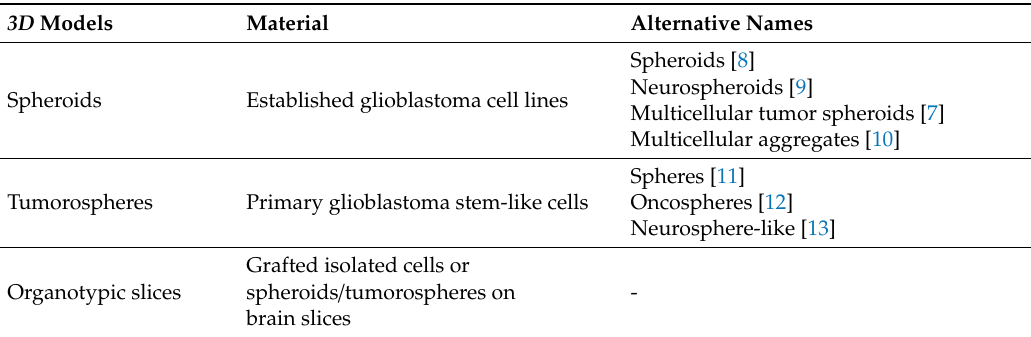
Table 1. 3D human glioblastoma models terminology found in the literature.